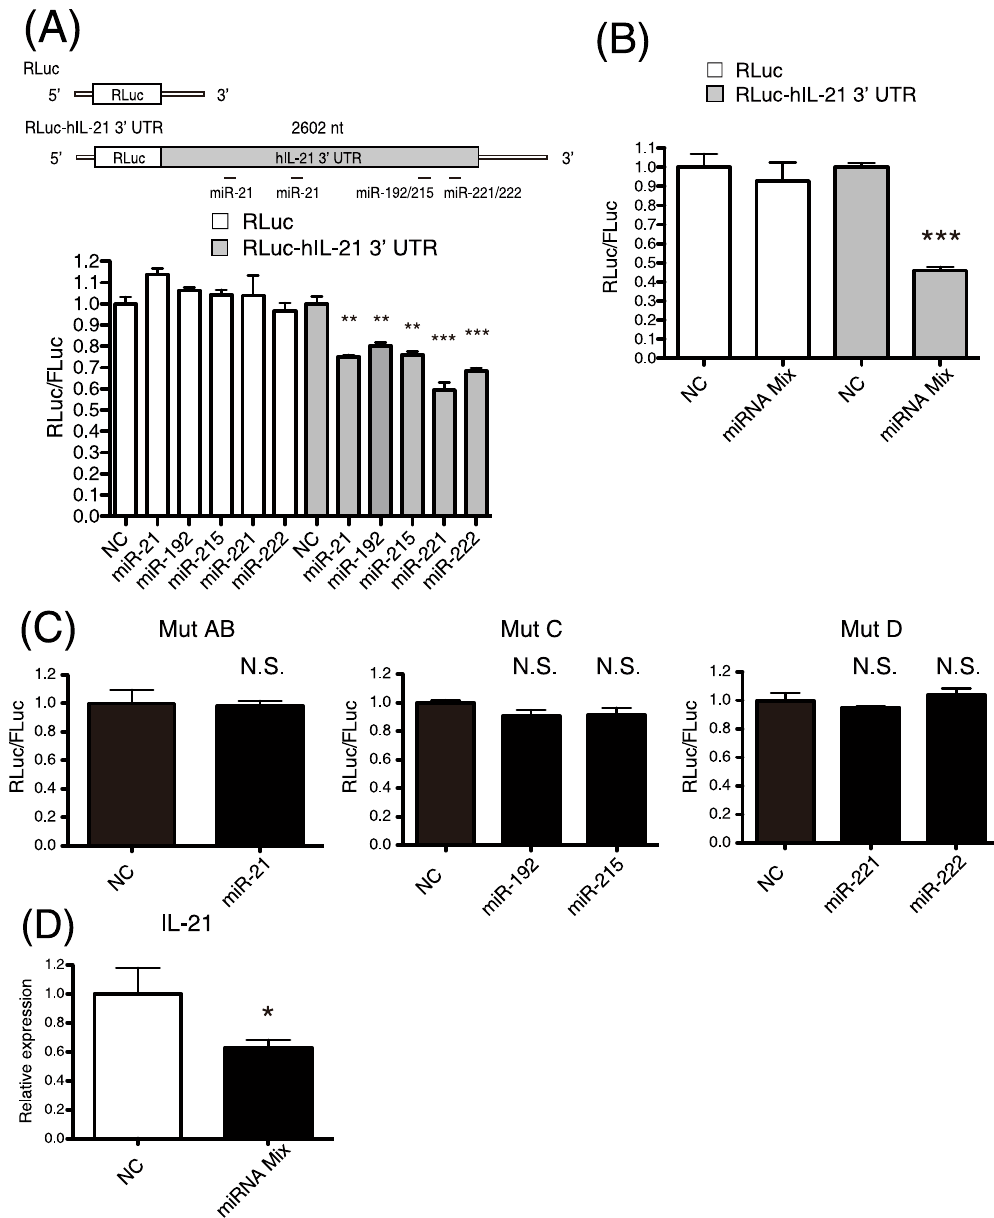
Figure 3. The expression of human IL-21 was suppressed by miRNAs. ( A ) 293 T cells were co-transfected with a reporter vector (Renilla or Renilla-hIL-21 3 ′ UTR), a transfection control vector (pGL3-control), and negative control RNA (NC) or miRNA. Final concentration of NC or miRNAs was 100 nM. Luciferase assays were performed at 24 hours after the transfection. ( B ) Luciferase assays were performed as described in ( A ). NC (final 250 nM) or mixture of miR-21, 192, 215, 221, and 222 (final 50 nM each) were co-transfected into 293 T cells. ( C ) Luciferase assays were performed as described in (A) with reporter vectors with mutant 3 ′ UTR of human IL-21. ( D ) NC (final 250 nM) or mixture of miR-21, 192, 215, 221, and 222 (final 50 nM each) were co-transfected into human Th2 cells. Relative expression levels of IL-21 mRNA were examined by quantitative real-time RT-PCR at 24 hours after the transfection. The expression levels were normalized to GAPDH. Data are shown as means + SEM of four independent experiments performed. ( A – D ) Data shown are a single experiment representative of three independent experiments performed. * P < 0.05, ** P < 0.01, *** P < 0.001. N.S., not